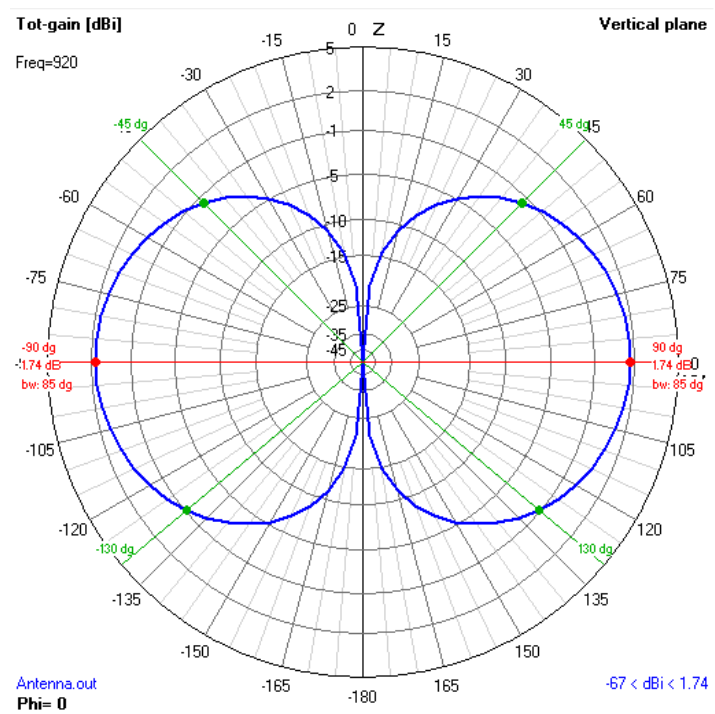
Figure 15. Analysis of the best position of XBee antenna by simulation using 4nec2 software.